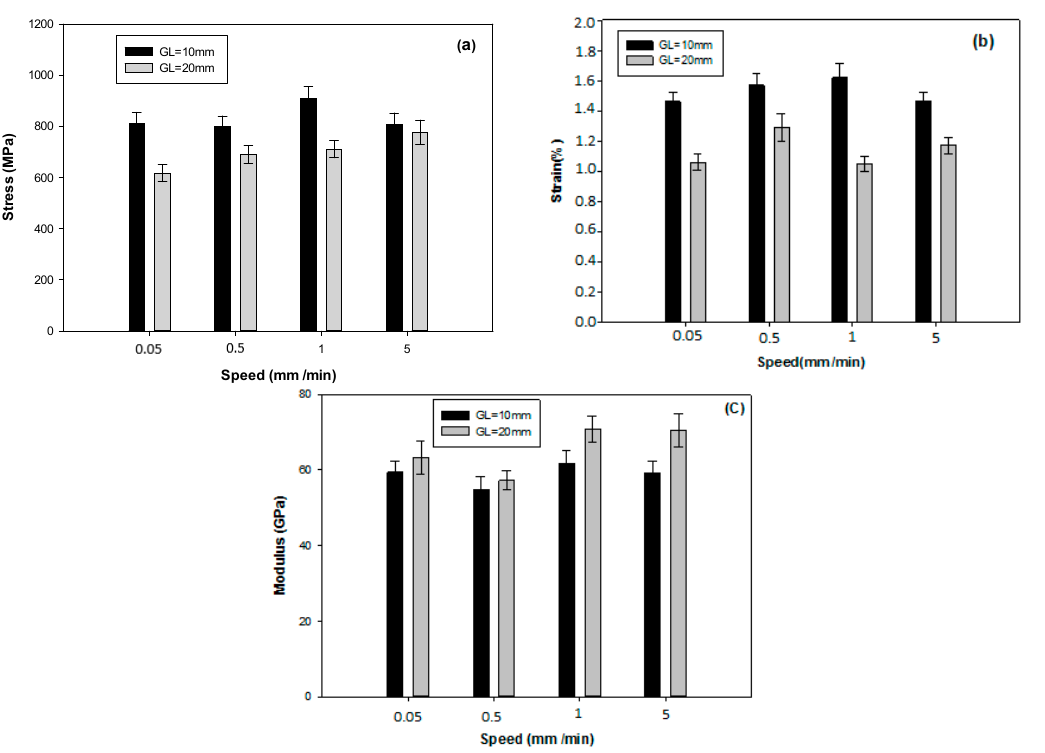
Figure 3. Tensile properties per test speed and gage length. ( a ) Stress data scatter, ( b ) Strain data scatter, and ( c ) Young’s modulus data scatter.